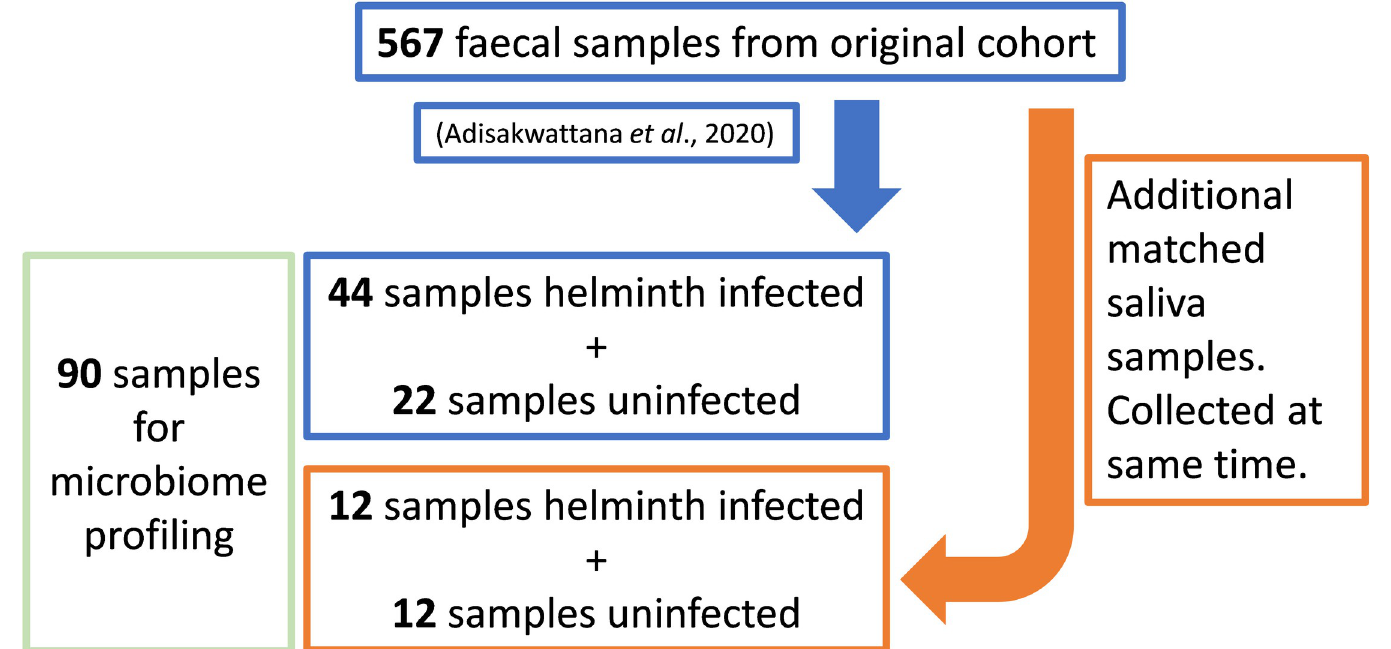
Fig 1. Study design of samples selected for microbiota profiling. From the original cohort [6], a subset of faecal samples was selected and of these a further subset of matched saliva samples, were used for 16S profiling.